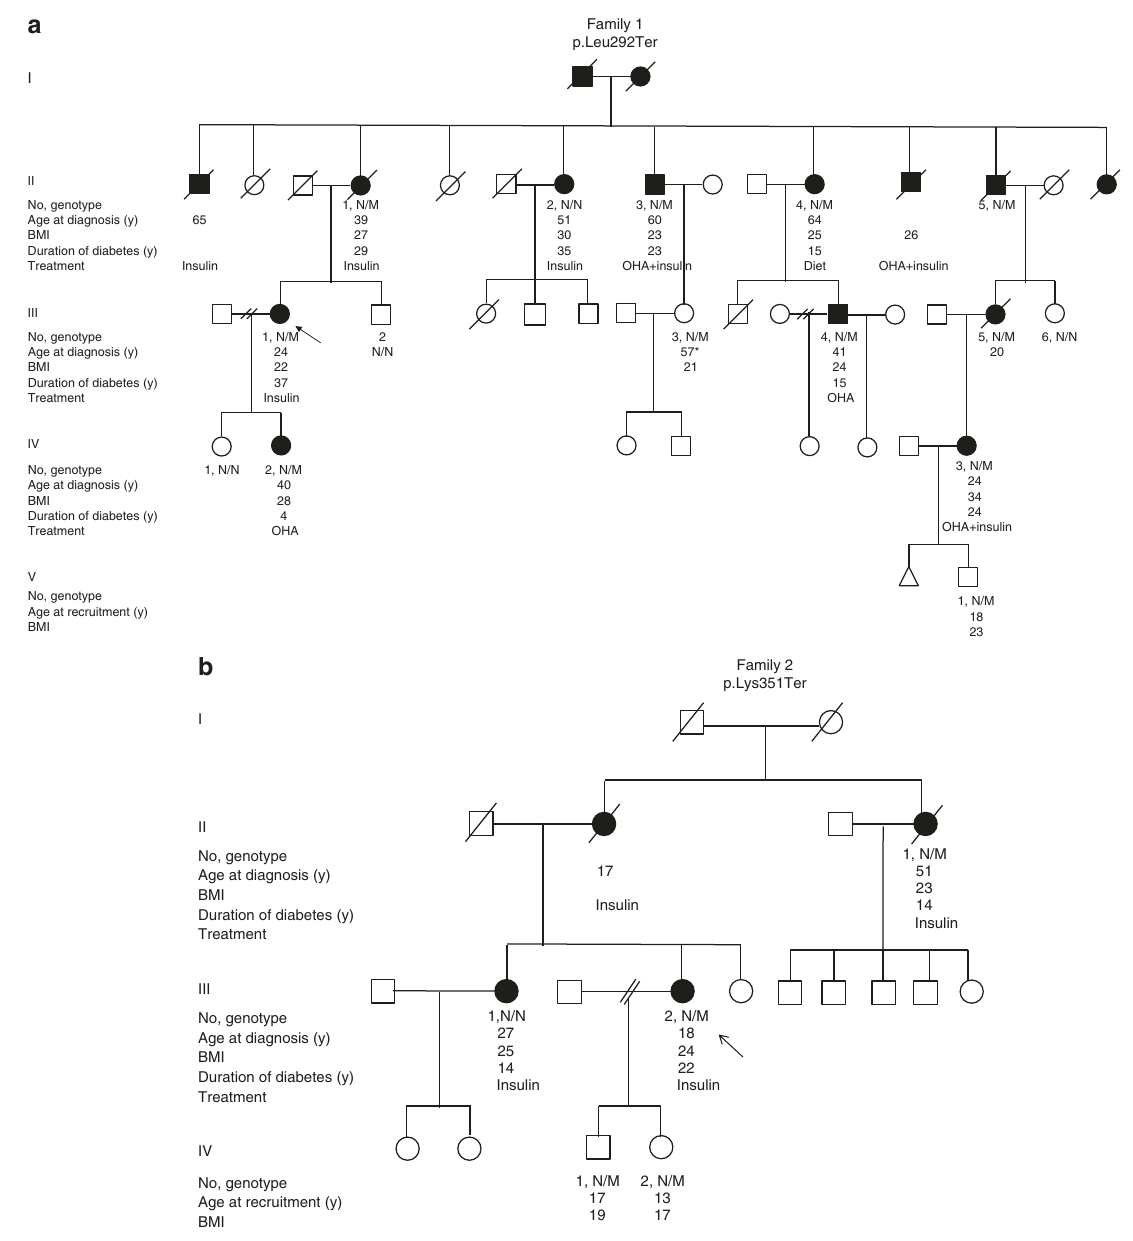
Fig. 1 Extended pedigree of non-Finnish European patients identi fi ed in the discovery cohort. a Pedigree of family 1 that were identi fi ed with heterozygous RFX6 variant (NM_173560.3:c.875-T > G,p.Leu292Ter) from the discovery cohort. b Pedigree of family 2 from the discovery cohort with heterozygous